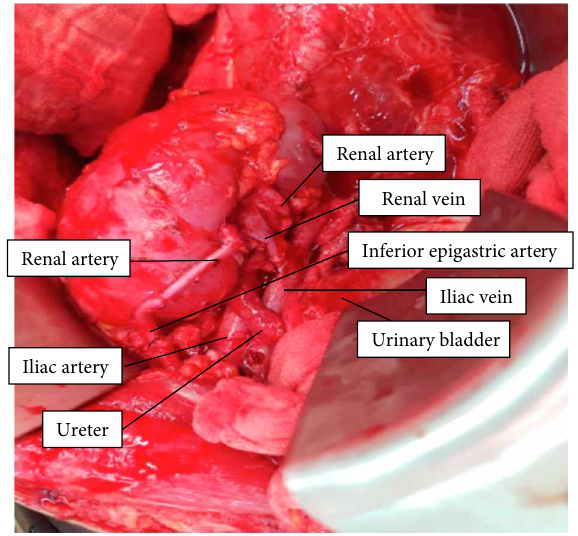
Figure 3: The autotransplanted right